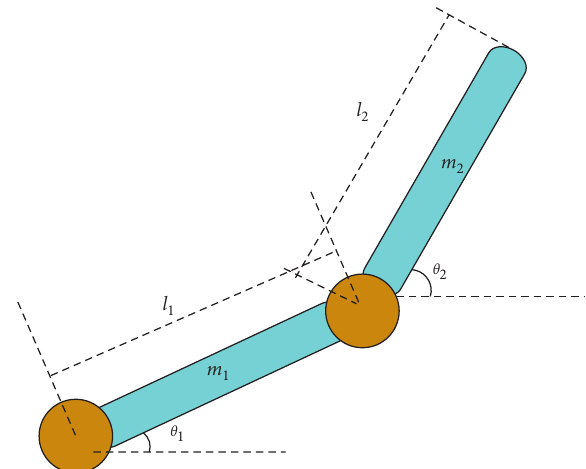
Figure 1: Simplified model of 2-DOF